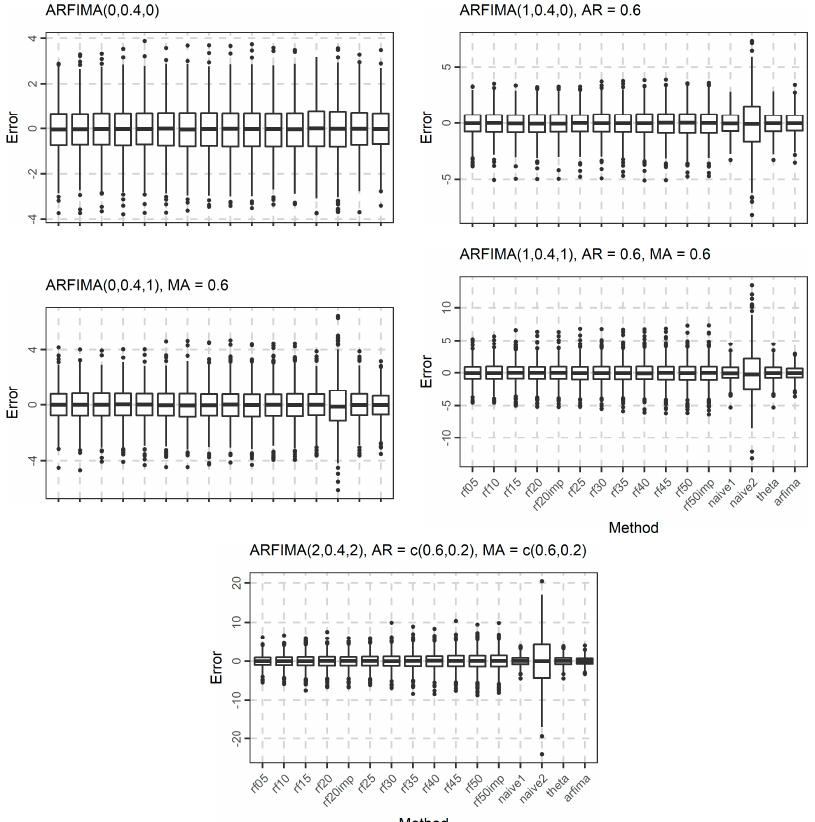
Figure 9. Boxplots of the errors when forecasting the 101st value of 1000 simulated time series from each ARFIMA model used in the present study.